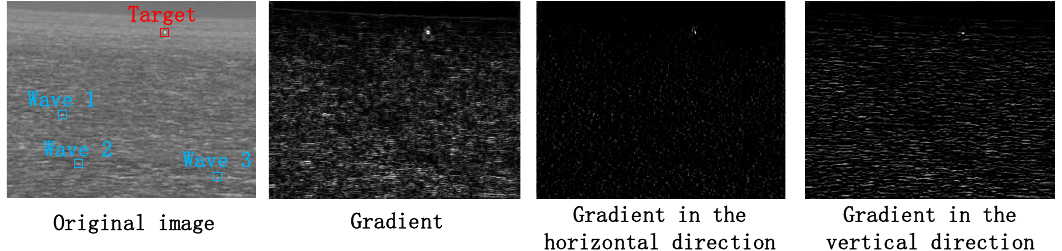
Figure 4. Gradient distribution of waves and targets.